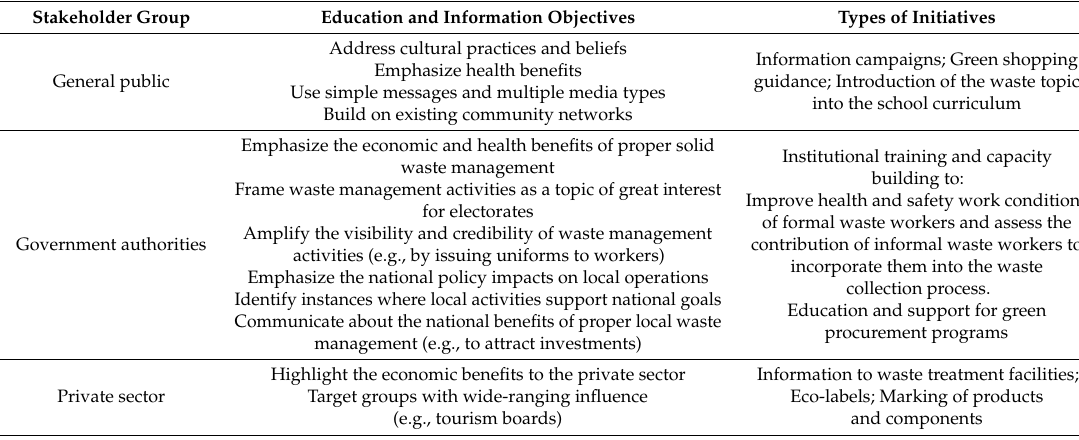
Table 1. Selected waste education and information strategies for different stakeholder